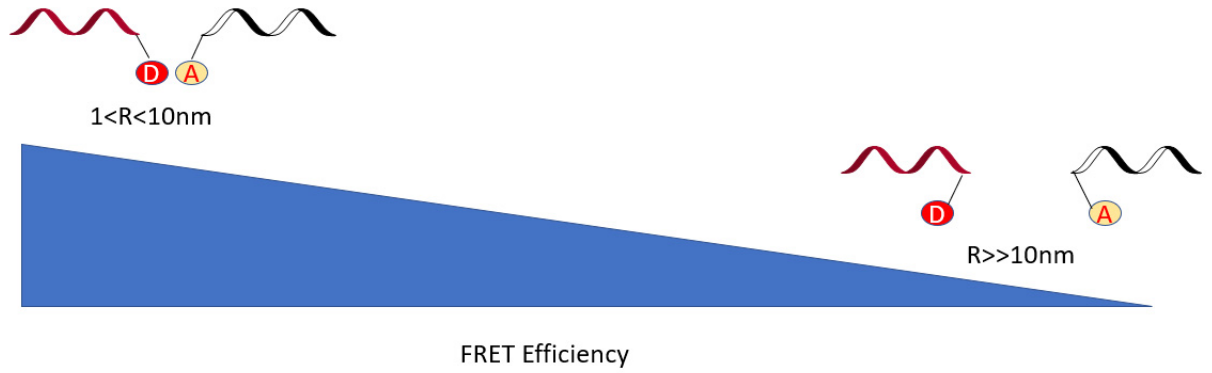
Figure 9. The relationship between donor and acceptor dye distances and the efficiency of fluores- cence resonance energy transfer (FRET). Theoretically, the quantum yield and FRET efficiency are lower when the dyes are farther apart.